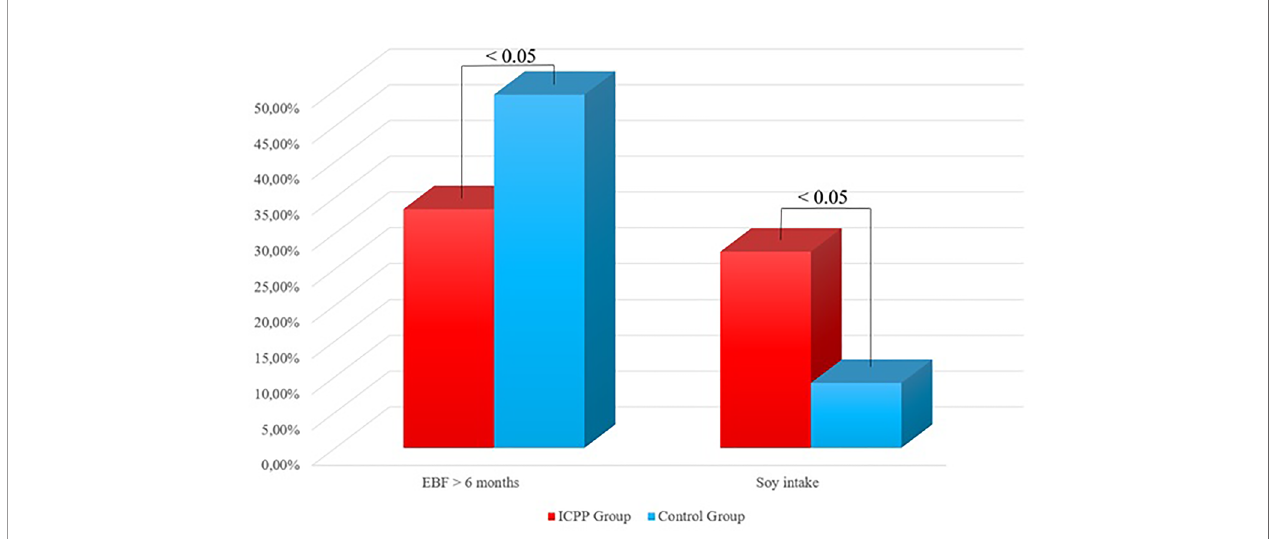
FIGURE 1 | Comparison regarding EBF and soy intake between